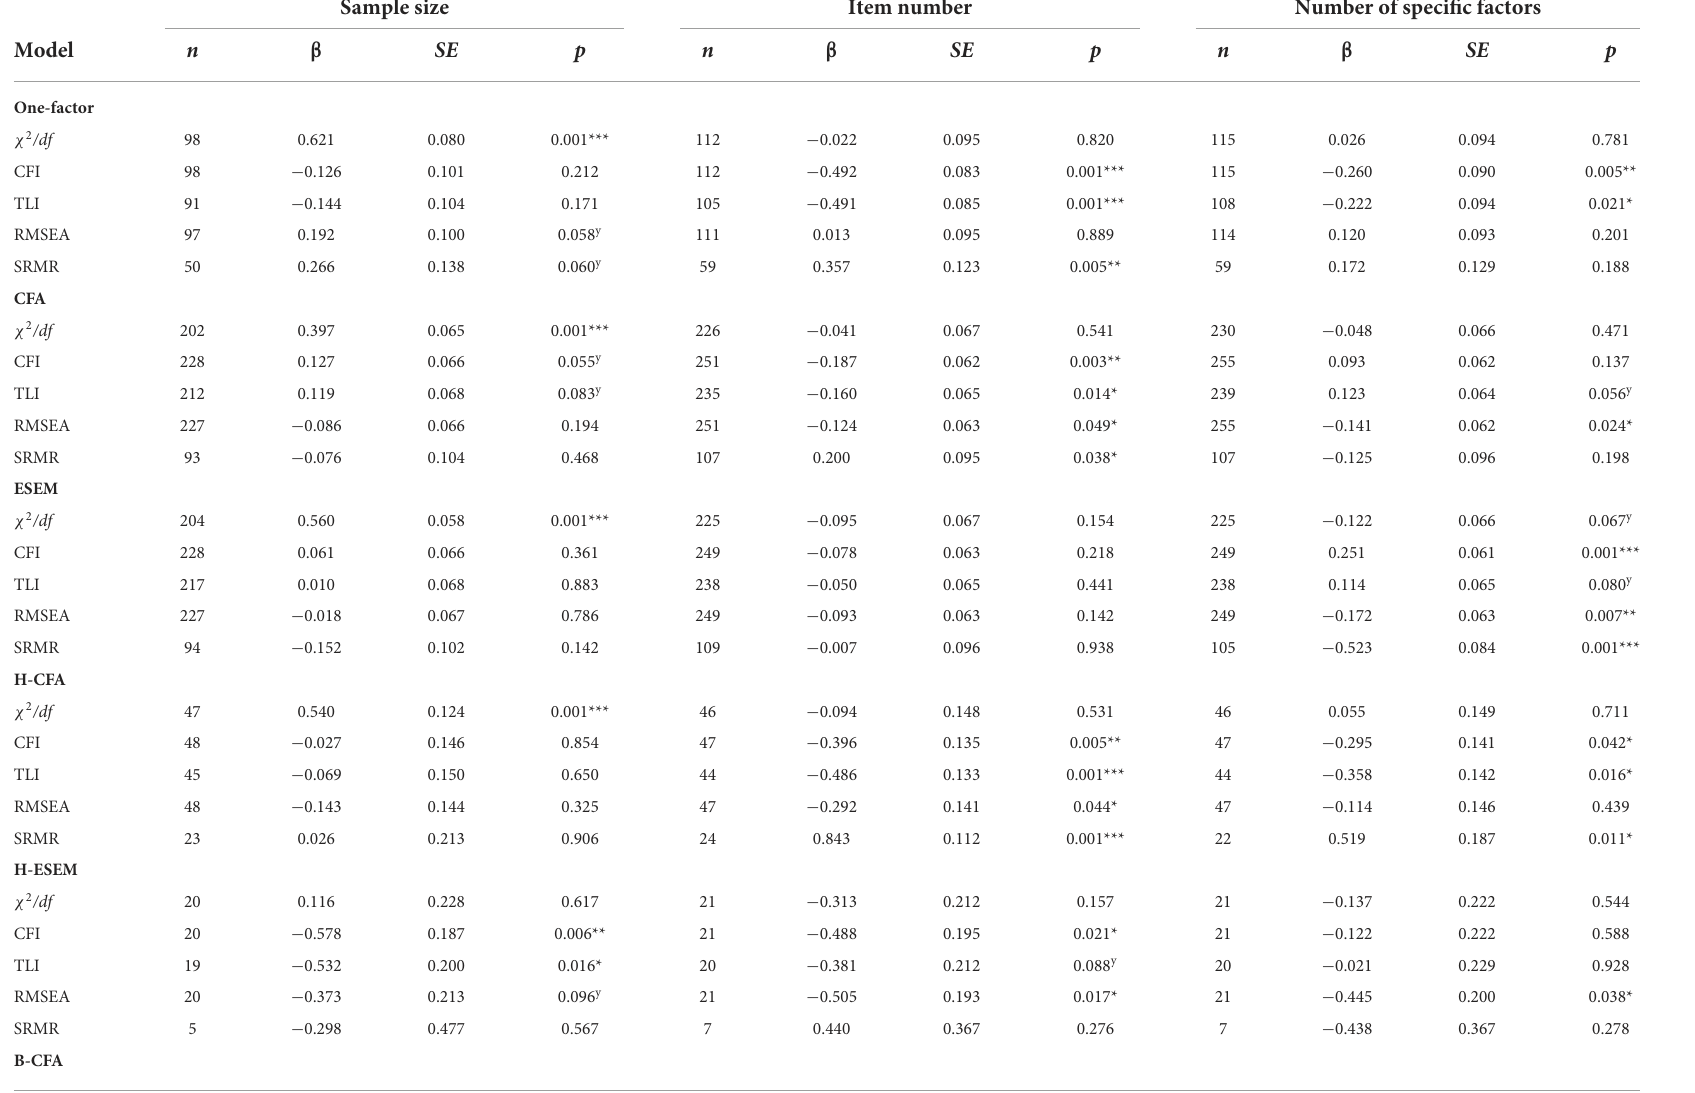
TABLE 10 Between-Study analysis of the influence of sample size, item number, and specific factor number on model